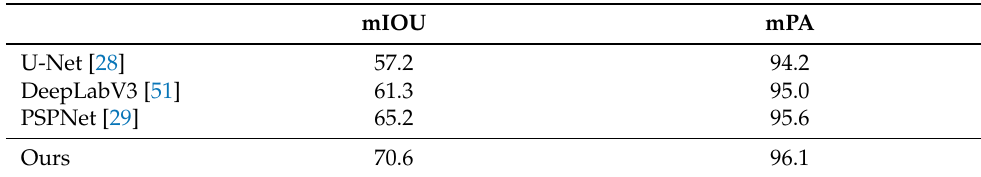
Table 1. Quantitative evaluation of segmentation on SIAT